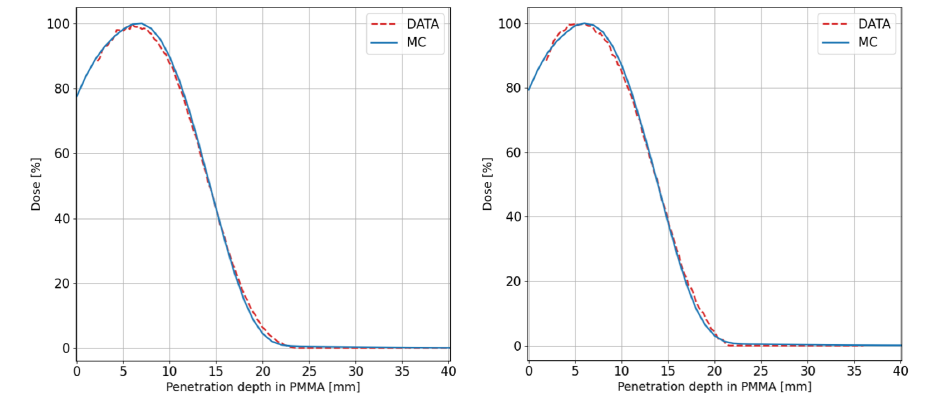
Figure 6. Measured (dotted red line) and simulated (continuous blue line) PDD in the PMMA phantom obtained for the 5 MeV electron beam collimated with the A-d30 ( left ) and A-d120 ( right )